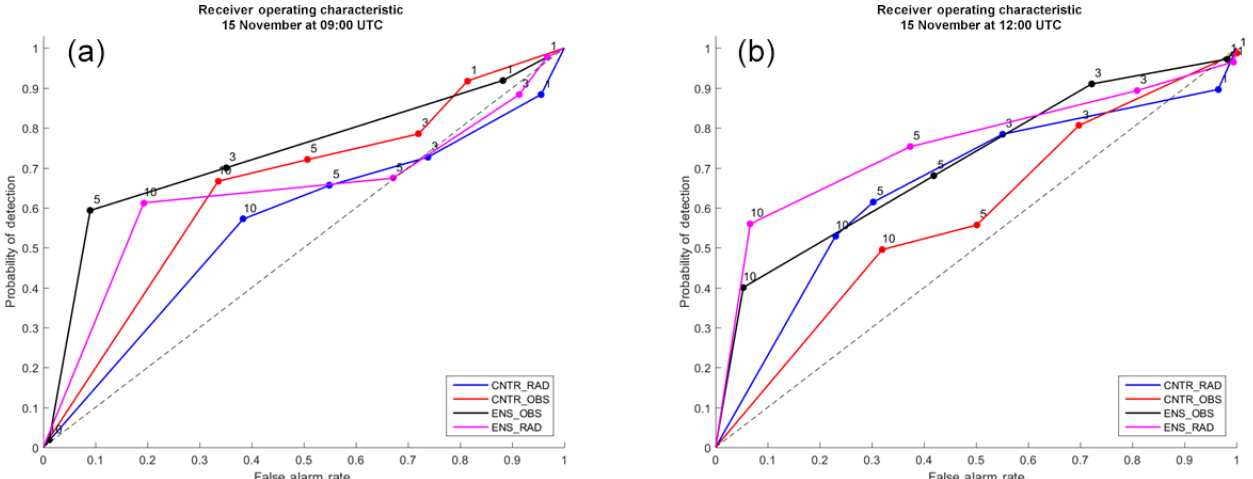
Figure 7. Receiver operating characteristic curves using both rain gauge (OBS) and radar (RAD) SRT for the WRF regional ensemble (black and magenta respectively) and CNTR (red and blue respectively) on 15 November at (a) 09:00UTC and (b)